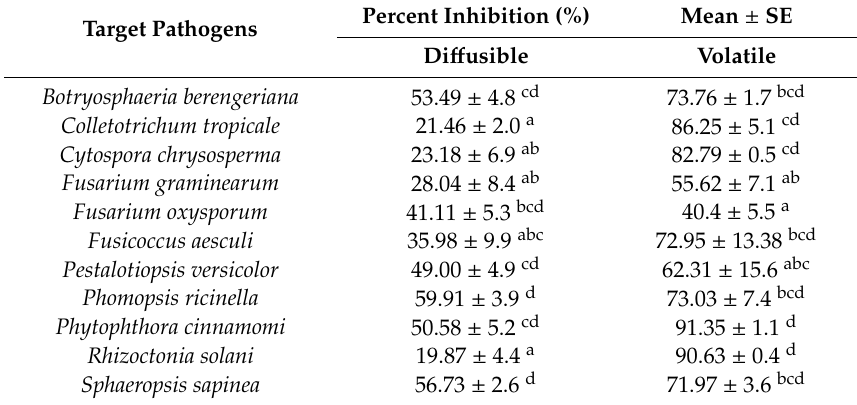
Table 2. Mycelia growth of phytopathogenic fungi inhibited by strain